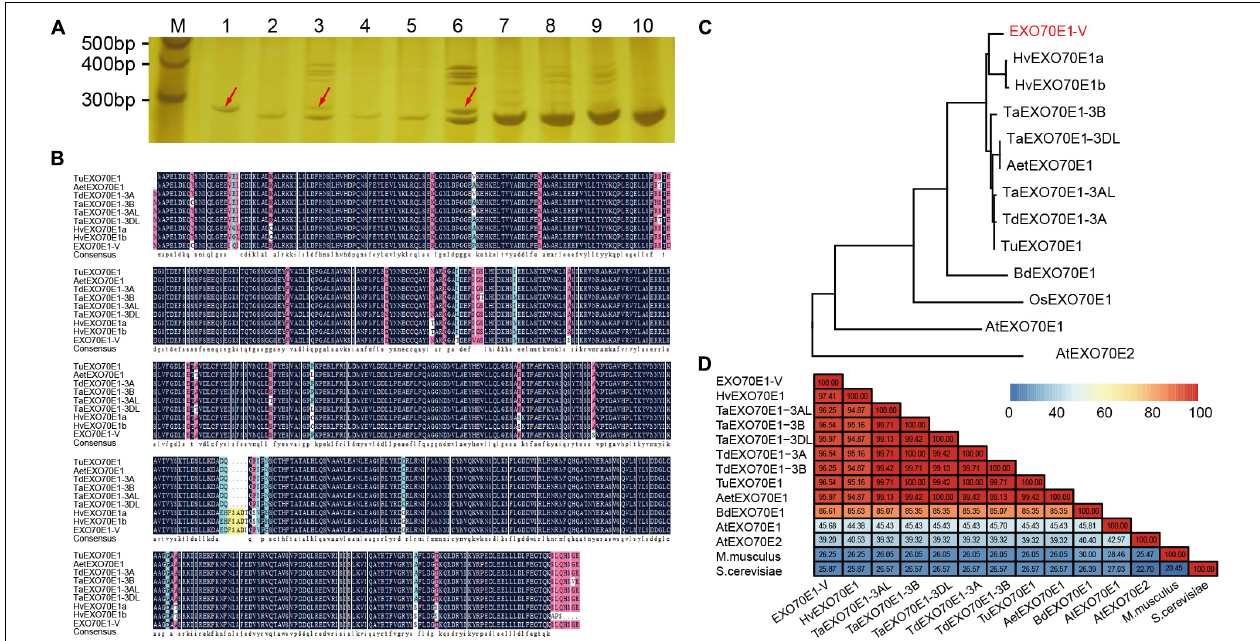
FIGURE 2 | The sequence analysis of EXO70E1-V. (A) Chromosomal location of EXO70E1-V using a set of wheat- Haynaldia villosa addition lines. M, 20 bp DNA Ladder; 1, H . villosa ; 2, Chinese Spring (CS); 3, Triticum durum – H . villosa amphiploid (AABBVV); 4–10, DA1V–DA7V. The red arrow indicates the target band. (B) Alignment of EXO70E1 ortholog proteins in different Triticeae species. (C) Phylogenetic analysis of EXO70E1-V and its orthologs in Triticeae species, Brachypodium distachyon , Oryza sativa , and Arabidopsis thaliana . The EX070 gene from H. villosa is marked in red. (D) Sequence similarity analysis of EXO70E1 ortholog proteins in Triticeae species, A. thaliana , M. musculus , and S. cerevisiae . Tu, Triticum urartu ; Aet, Aegilops tauschii ; Td, Triticum dicoccoides ; Ta, Triticum aestivum ; Hv, Hordeum vulgare ; –V, Haynaldia villosa ; Os, Oryza sativa; Bd, Brachypodium